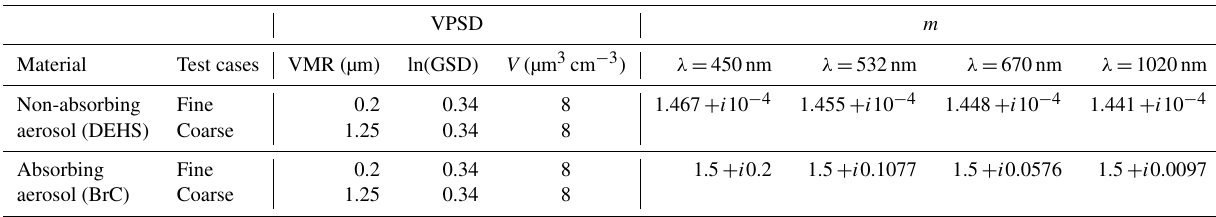
Table 3. State parameters ( x 0 ,i ) and their values for the unimodal-aerosol test cases. VPSD m Material